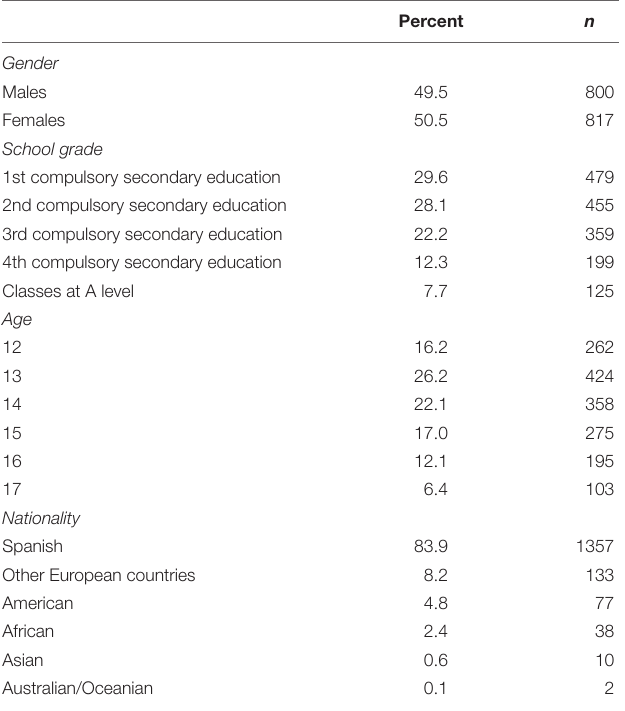
TABLE 1 | Demographic characteristics of the sample.